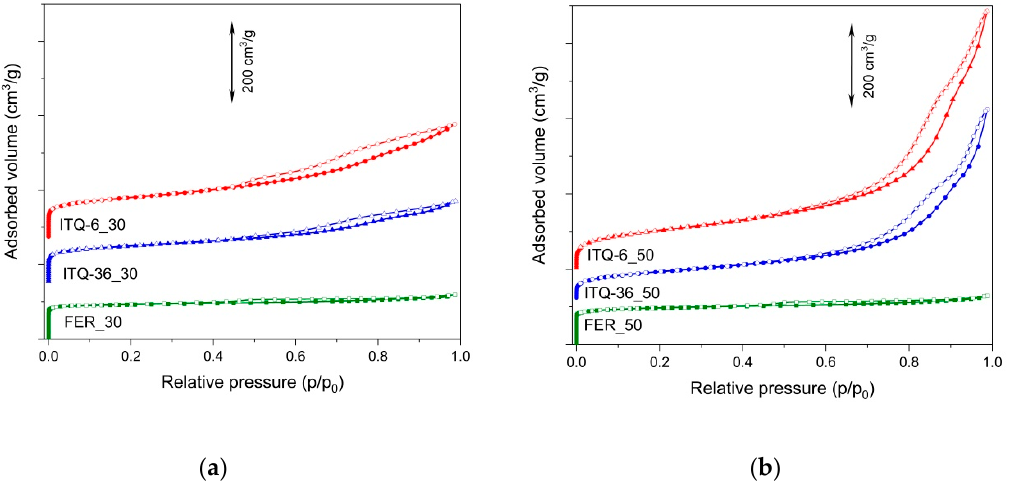
Figure 2. Nitrogen adsorption – desorption isotherms of the FER, ITQ-6 and ITQ-36 samples with Si / Al molar ratios of 30 ( a ) and 50 ( b ). Table 1. Textural and acidic properties of the samples before and after modification with Cu.